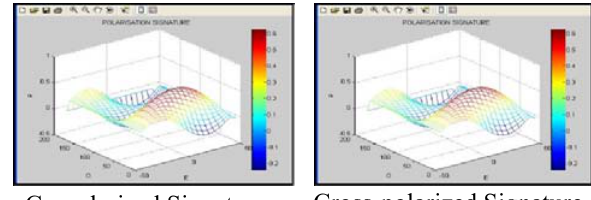
Figure 3.2(b): Polarimetric response of Road-2